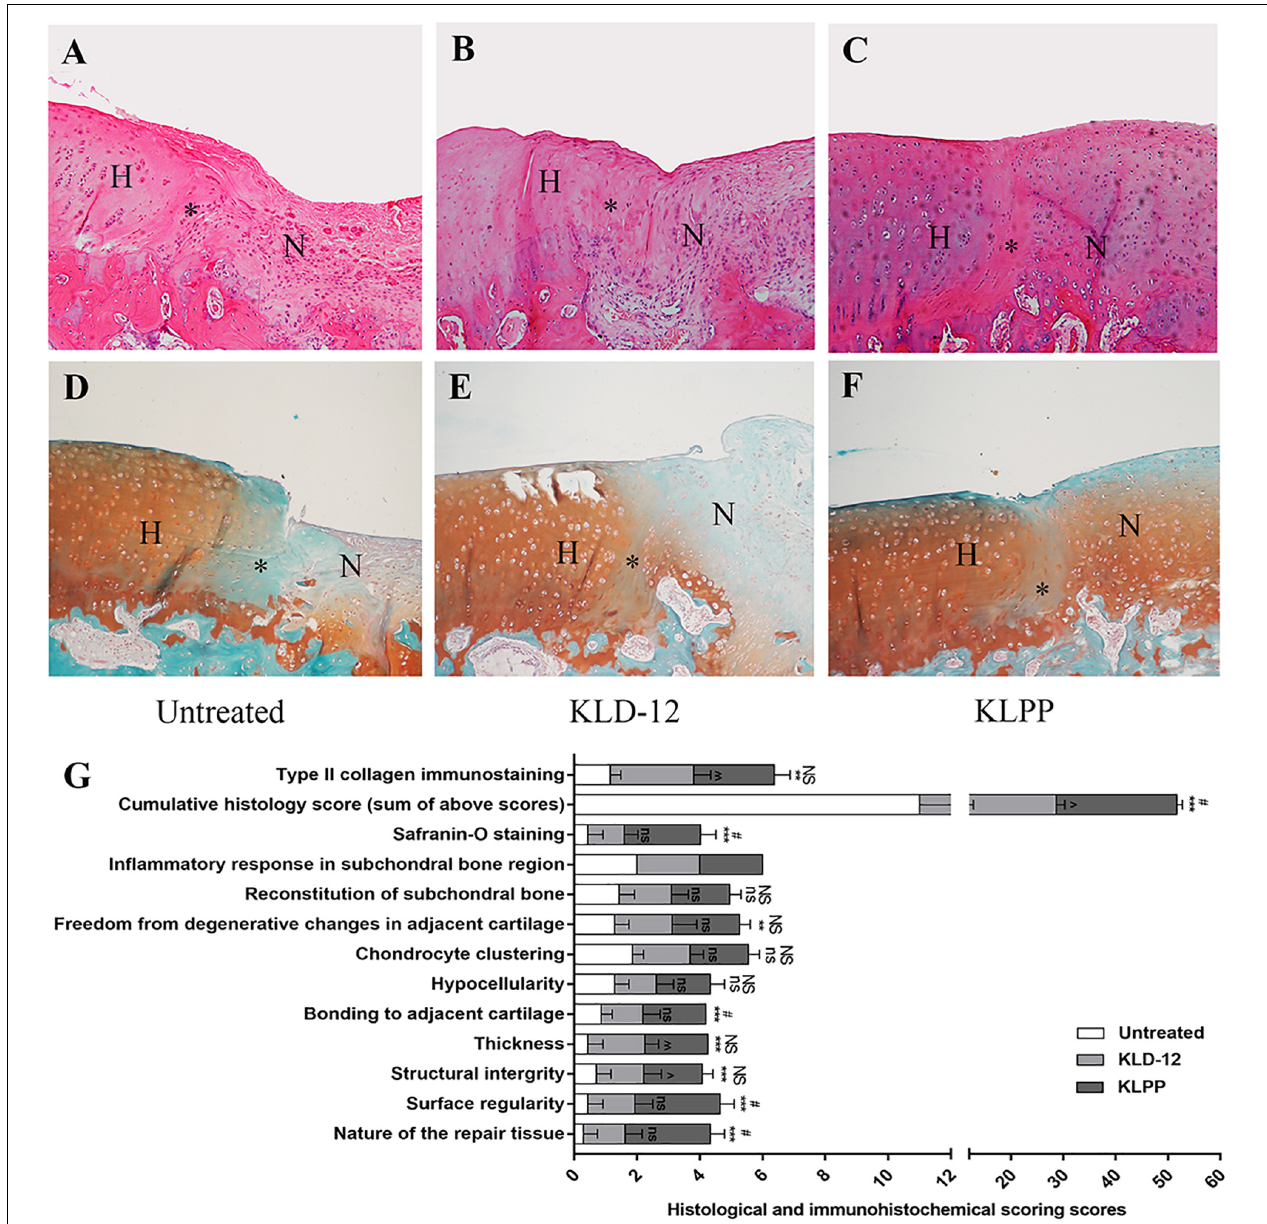
FIGURE 7 | H&E staining (A–C) and Safranin-O/Fast green staining (D,E) of repaired cartilage. Images showing evaluation of untreated defects (A,D) and defects treated with KLD-12 hydrogel (B,E) and KLPP hydrogel (C,F) . (Magnification × 100). (H, host cartilage; N, neo-cartilage; *, the interface between neo-cartilage and host cartilage). (G) Histological and immunohistochemical scores at 12 weeks. ( n = 3, mean ± SD. *, ns, KLPP vs. Untreated, * p < 0.05, ** p < 0.01, *** p < 0.001; #, NS, KLPP vs. KLD-12, # p < 0.05, ## p < 0.01, ### p < 0.001; ∧ , ns, KLD-12 vs. Untreated, ∧ p < 0.05, ∧∧ p < 0.01. NS/ns: no